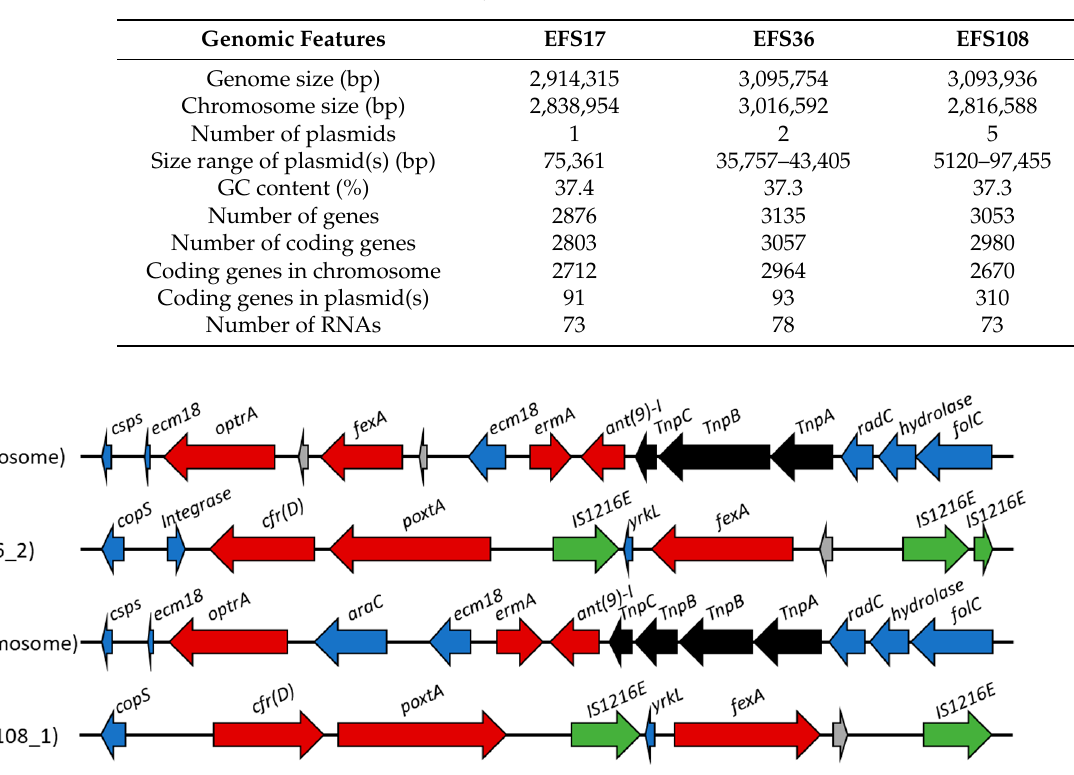
Figure 2. Schematic representation of phenicol-oxazolidinone resistance genes loci in three E. faecalis genomes. Genes and their orientation are shown with arrows and labeled; red, green, black, blue, and gray indicate antibiotic resistance gene, insertion sequences (ISs), transposase, known proteins, and hypothetical proteins, respectively. Csps, cold shock protein of CSP family; ecm18 , class I SAM-dependent methyltransferase; radC , DNA repair protein RadC; folC , dihydrofolate synthase; yrkL , NAD(P)H oxidoreductase YRKL.